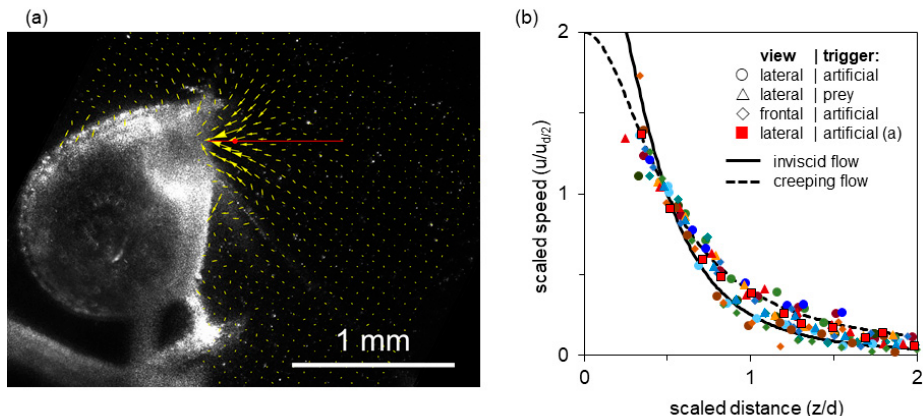
Figure 3. Flow generated by a bladderwort trap. ( a ) Single video frame obtained near peak flow (0.2 m s − 1 ), with the corresponding PIV vector field superimposed (field of view 1.9 × 1.9 mm 2 ). Indicated by a red line is the axial transect shown in ( b ); the half-gape point is marked with a red dot. ( b ) Fluid speed as a function of distance from the mouth along the axial transect; distances are normalized by gape diameter d and flow speeds normalized by the speed at half gape diameter u d / 2 . Data are shown for 15 suction events (event in ( a ): red squares). Both axes have been scaled to match dimensionless theoretical curves for entry flow through a circular orifice: inviscid flow (solid line) and creeping flow (dashed line), see main text (Discussion). Thus data and theory necessarily intersect at distance = 1/2, speed = 1.